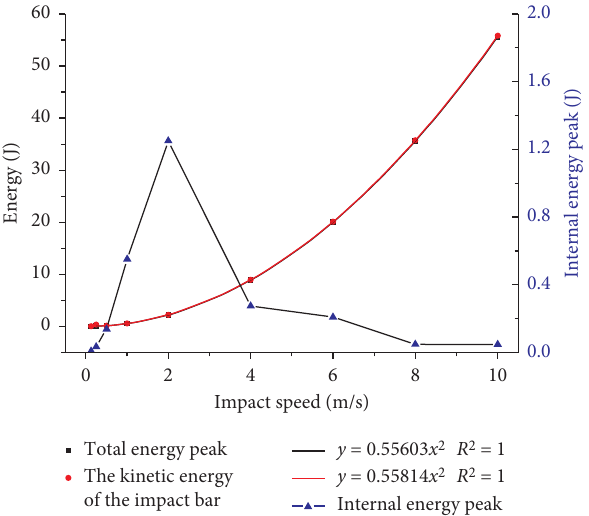
Figure 9: Energy and